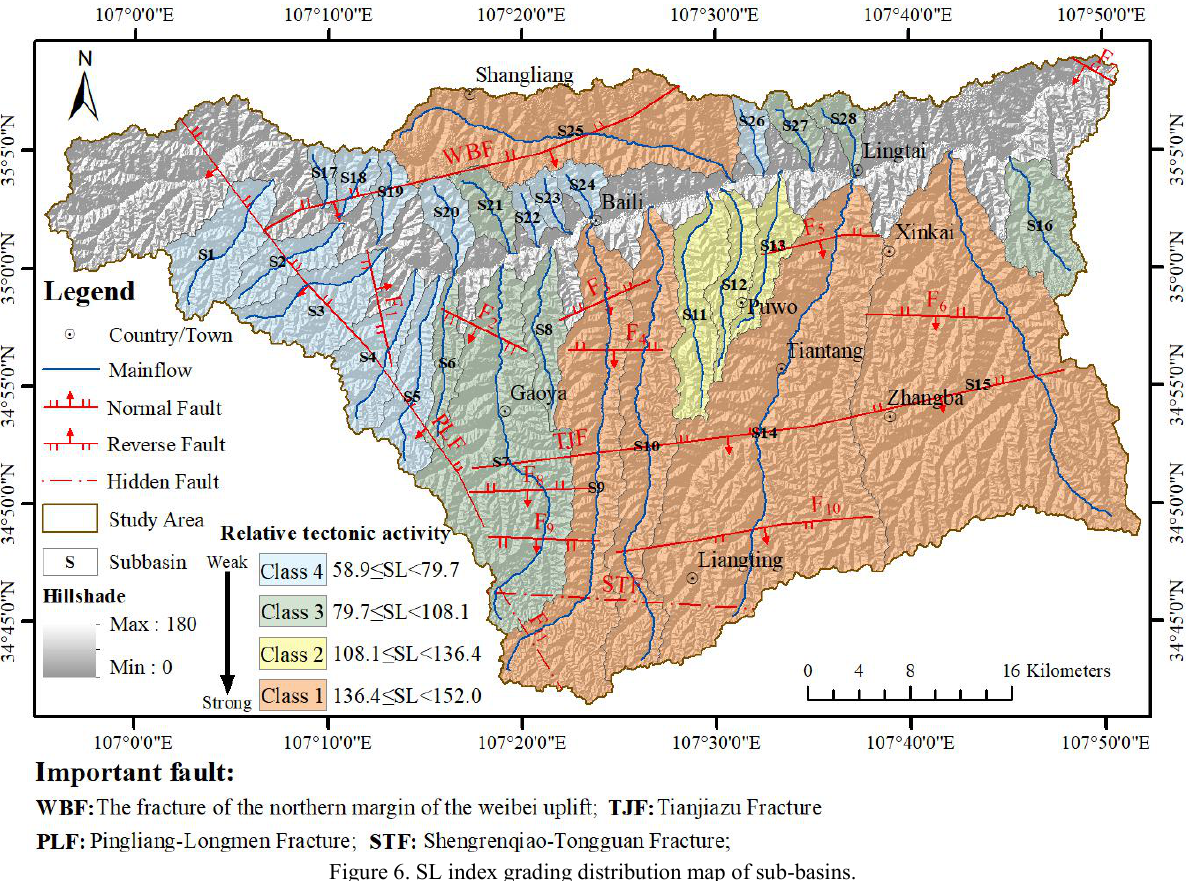
Figure 6. SL index grading distribution map of sub-basins.